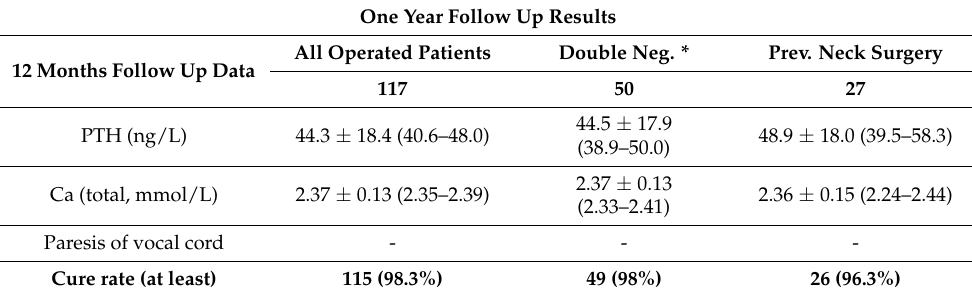
Table 4. Twelve months biochemical follow up data and cure rate of patients operated after imaging with FEC-PET-CT. Data are presented from the entire cohort of 147 patients enrolled between July 2017 and June 2020 and the subgroups with previous thyroid and parathyroid surgery. Qualitative data are expressed as numbers; continuous data as mean ± SD and 95% confidence interval.